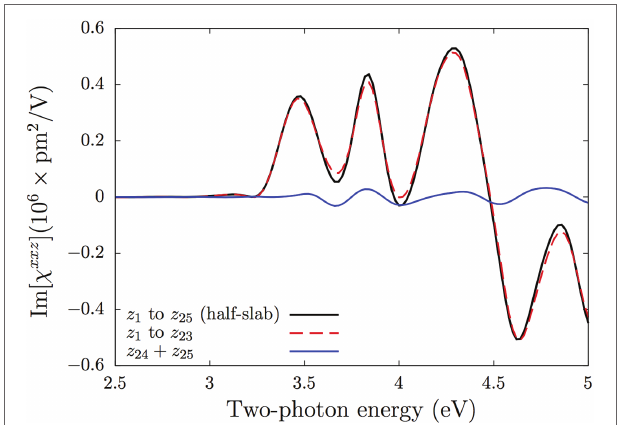
FIGURE 3 | Imaginary part of (cid:31) xxz ( z n ) from different layer sums . The solid black line is the sum of all 25 layers (1 H + 24 Si) that comprise the half-slab ( χ xxz hs ) ; the dashed blue line is the sum of the first 23 layers, and the solid red line is the sum of the last two layers ( z 24 + z 25 ). Note the consistency with equation (12), since the last two layers have a relatively small contribution to the overall spectrum.